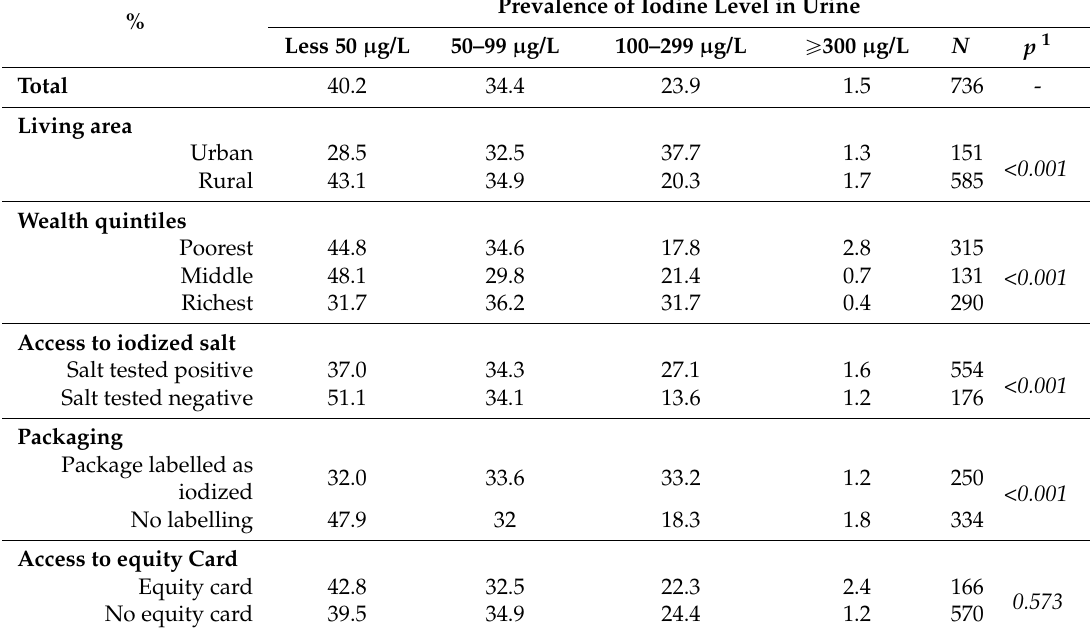
Table 2. Bivariate relationships between the prevalence of iodine level in urine and living area, wealth quintile, access to iodized salt, and access to equity card among mothers.